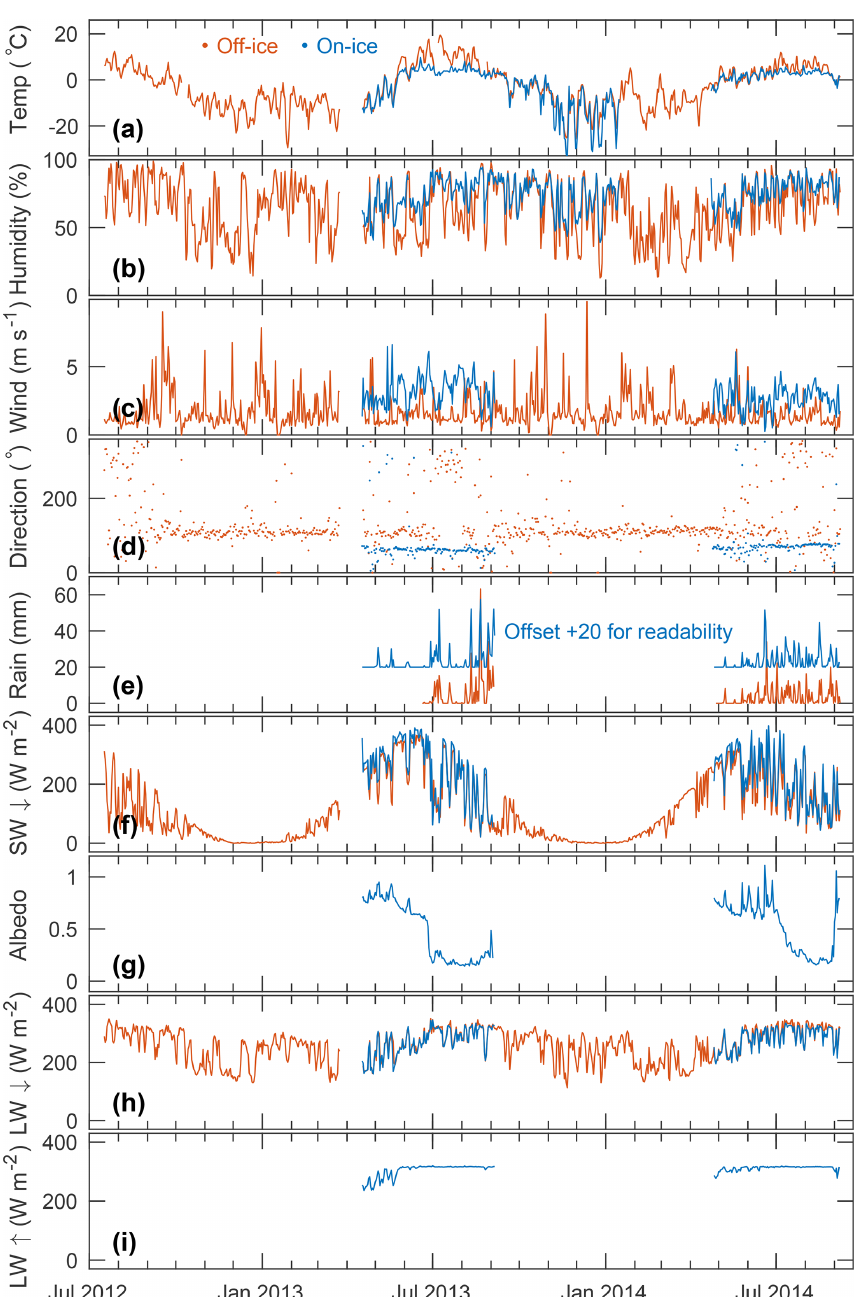
Figure 4. Meteorological data from the On-Ice and Off-Ice stations from July 2012 to September 2014. (a) Daily temperature, (b) relative humidity, (c) wind speed, (d) wind direction, (e) precipitation, (f) incoming shortwave (SW) radiation, (g) albedo, (h) incoming longwave (LW) radiation, and (i) outgoing LW radiation. All values are daily means except for precipitation, which is the daily sum. Data gaps occur in winter when some sensors were removed. The On-Ice temperature–humidity sensor was buried in the snowpack in mid-January 2014 and re-exposed during a station visit on 22 April 2014, so data are not included for that